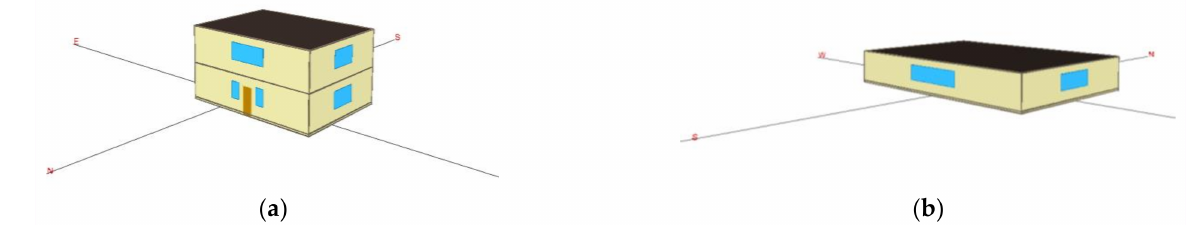
Figure 3. Rendering for energy models specific to ( a ) a detached house and ( b ) an apartment